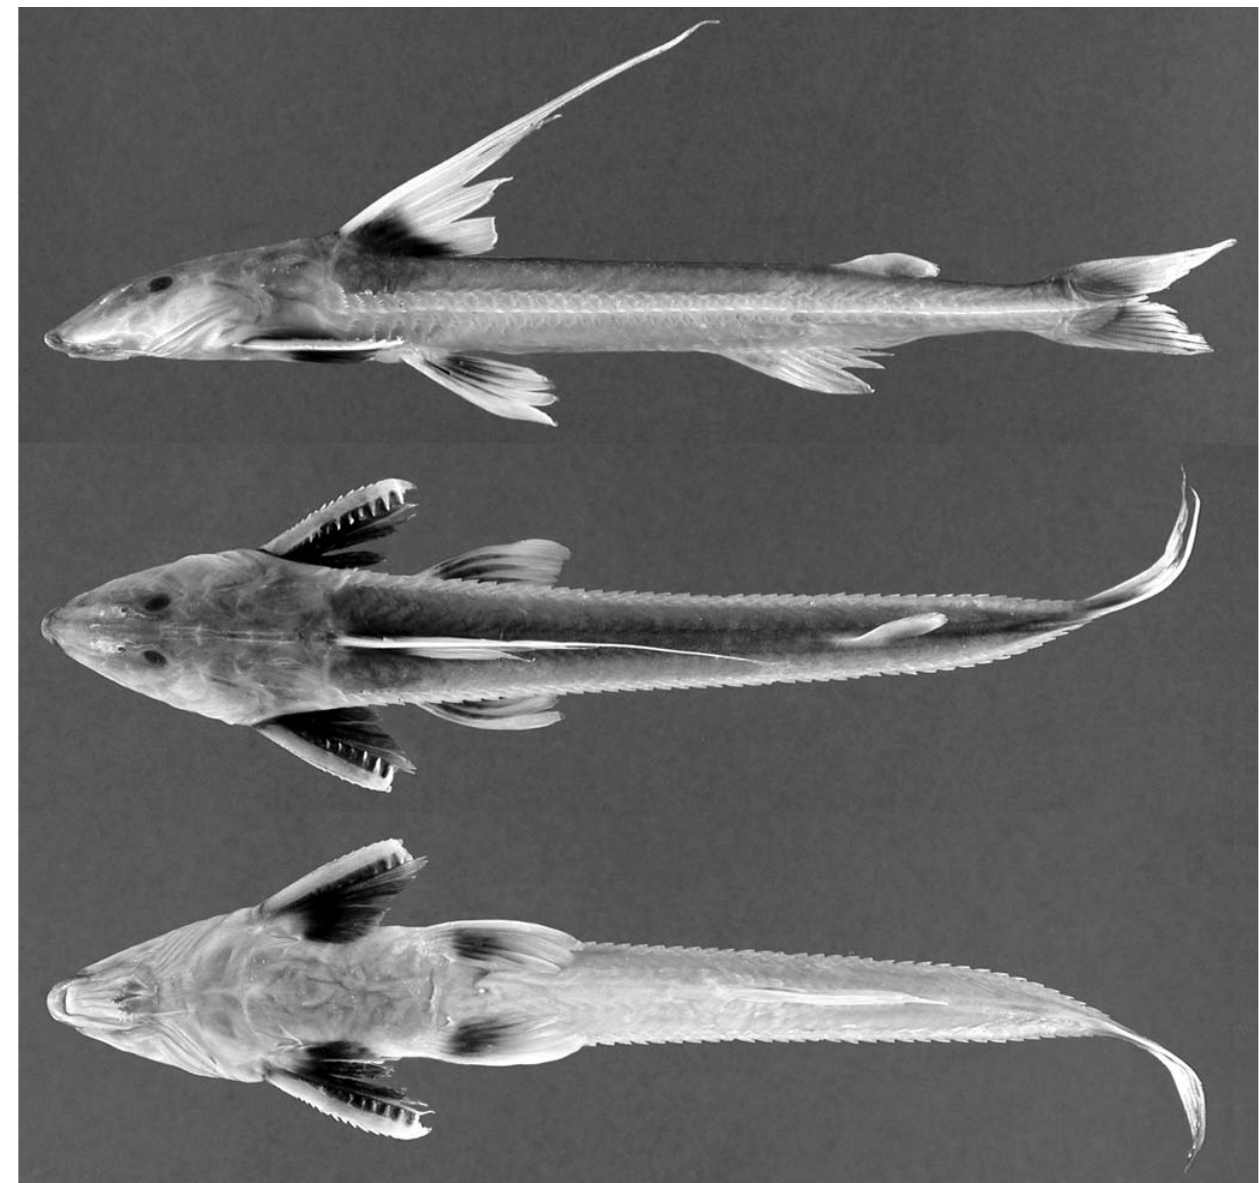
Fig. 26. Leptodoras juruensis , ANSP 180930 (SL 149 mm), rio Solimões (Amazonas dr.), 14 km upstream from Nova Tonantins,